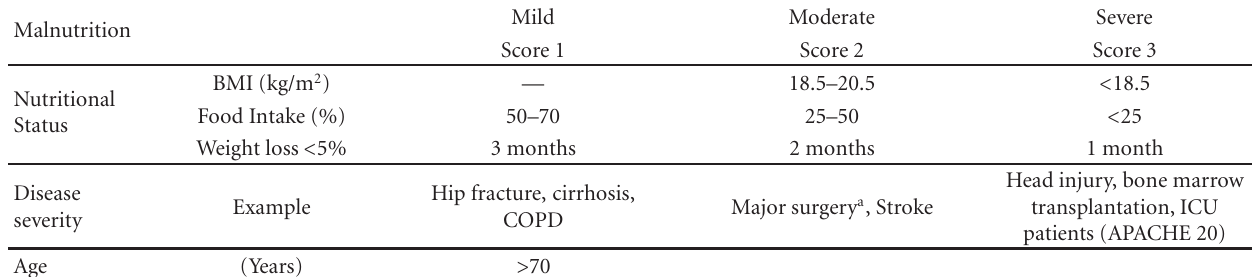
Table 1: Nutritional Risk Screening score (NRS 2002) [17]. The total score is obtained by adding the nutritional score to the disease score. Age > 70 years adds 1 to the total score. If age-corrected total is ≥ 3, the patient presents severe malnutrition, and nutritional support is recommended.